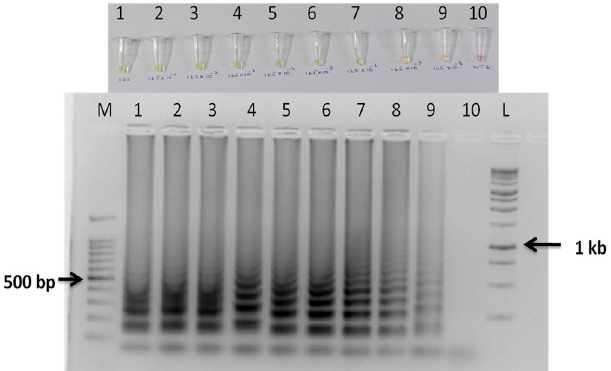
Figure 5. Sensitivity of the LAMP assay when performed with tenfold serial dilution of template DNA. M: 100 bp (Promega); 1: 165 ng/µl; 2: 165 × 10 –1 ng/µl; 3: 165 × 10 –2 ng/µl; 4: 165 × 10 –3 ng/µl; 5: 165 × 10 –4 ng/ µl; 6: 165 × 10 –5 ng/µl; 7: 165 × 10 –6 ng/µl; 8: 165 × 10 –7 ng/µl; 9: 165 × 10 –8 ng/µl; 10: No template control; L: 1 kb (Promega). Upper panel in the figure shows reaction tubes whereas lower panel shows agarose gel electrophoresis